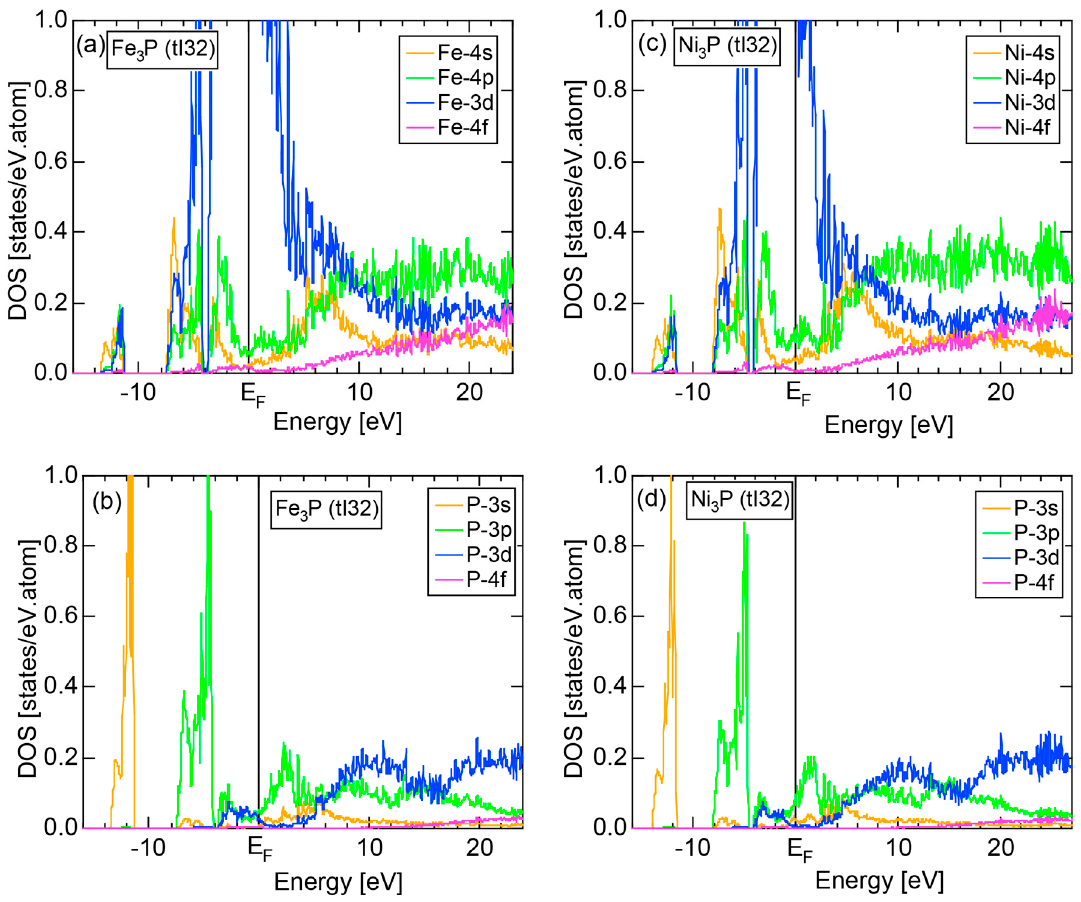
Figure 85. (a) Fe- and (b) P-pDOSs for Fe 3 P (tI32) and (c) Ni- and P-pDOSs for Ni 3 P (tI32) [11].